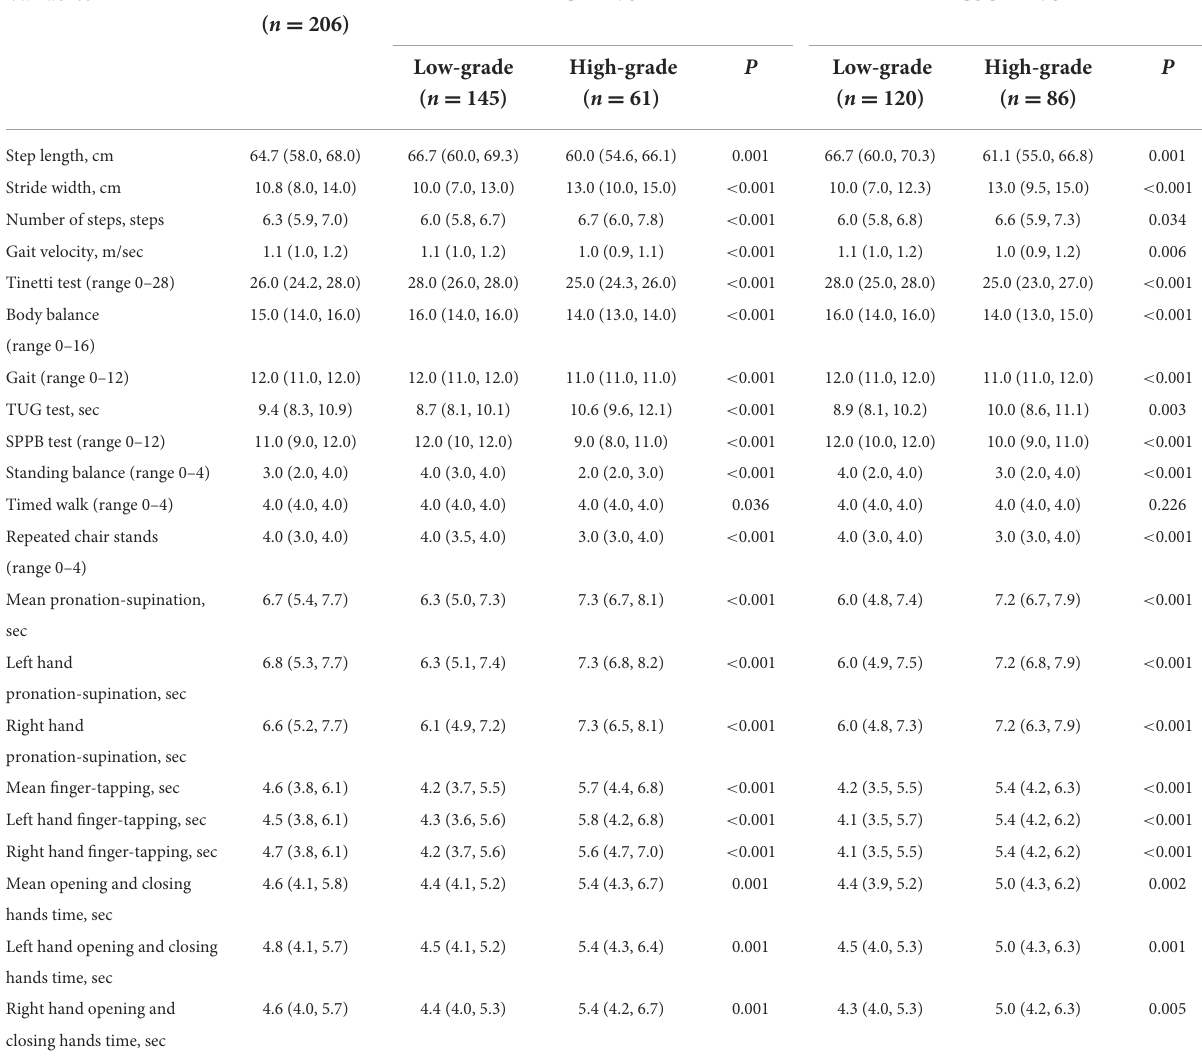
TABLE 2 Movement data of participants with different severities of